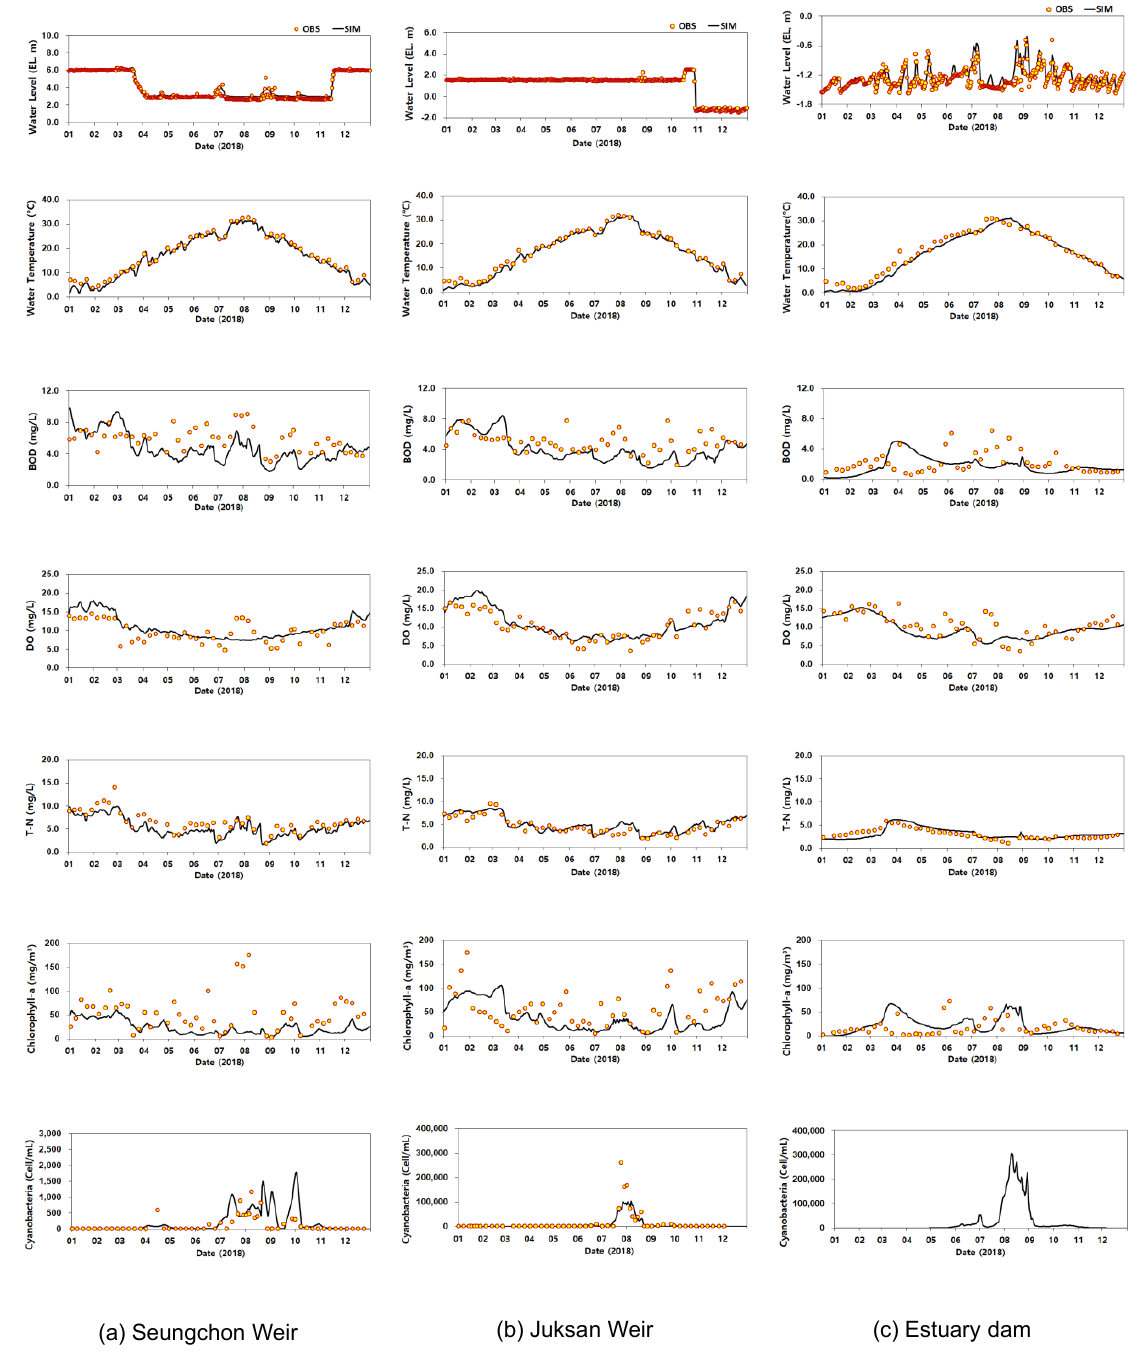
Figure 5. Comparison of observed and simulated values of water quality for the ( a ) Seungchon Weir, ( b ) Juksan Weir, and ( c ) estuary dam for 2018. The number of observed cyanobacterial cells is the sum of cell numbers for the genera Anabena, Aphanizomenon, Microcystis, and Oscillatoria. Table 6. Statistical summary of simulated and observed water quality at the Seungchon Weir, Juksan Weir, and estuary dam for 2018.